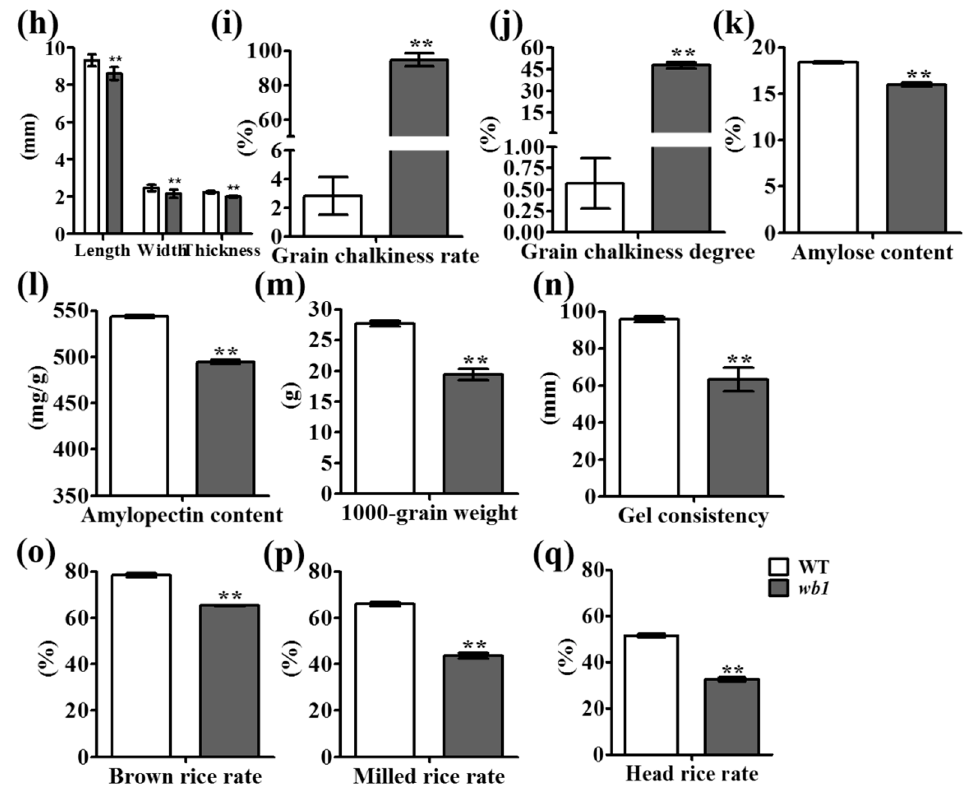
Figure 2. Phenotypic analyses of wb1 . ( a ) Comparison of representative WT and wb1 plant panicles; ( b , c ) Appearance of WT ( b ) and wb1 ( c ) grains; ( d , e ) Appearance of WT ( d ) and wb1 ( e ) white grains; ( f , g ) Scanning electron microscope images of WT ( f ) and wb1 ( g ) seed endosperm. Magnification, ×2000; ( h ) Measurements of seed length, width, and thickness of WT and wb1 grains ( n = 20); ( i ) Grain chalkiness rate comparison of WT and wb1 grains ( n = 6), and grain chalkiness rate is the rate of chalky grains in total grains; ( j ) Grain chalkiness degree comparison of WT and wb1 grains ( n = 6), and grain chalkiness degree is the grain chalkiness rate multiplied by grain chalkiness area (the percent area of chalk in a grain); ( k ) Amylose content comparison of WT and wb1 grains (0.05 g grain powder each, n = 3); ( l ) Amylopectin content comparison of WT and wb1 grains (0.01 g grain powder each, n = 3); ( m ) Comparison of 1000-grain weight of WT and wb1 ( n = 10); ( n ) Gel consistency comparison of WT and wb1 grains ( n = 4); ( o , p , q ) Comparisons of brown rice, milled rice and head rice rates of WT and wb1 (25 g paddy each, n = 3). Data are given as means ± SD (standard deviation). The asterisks represent statistical significance between WT and wb1 , determined by a student’s t -test (** p ≤ 0.01). Scale bars: ( a – e ) 10 mm; ( f , g ) 30 μ m.